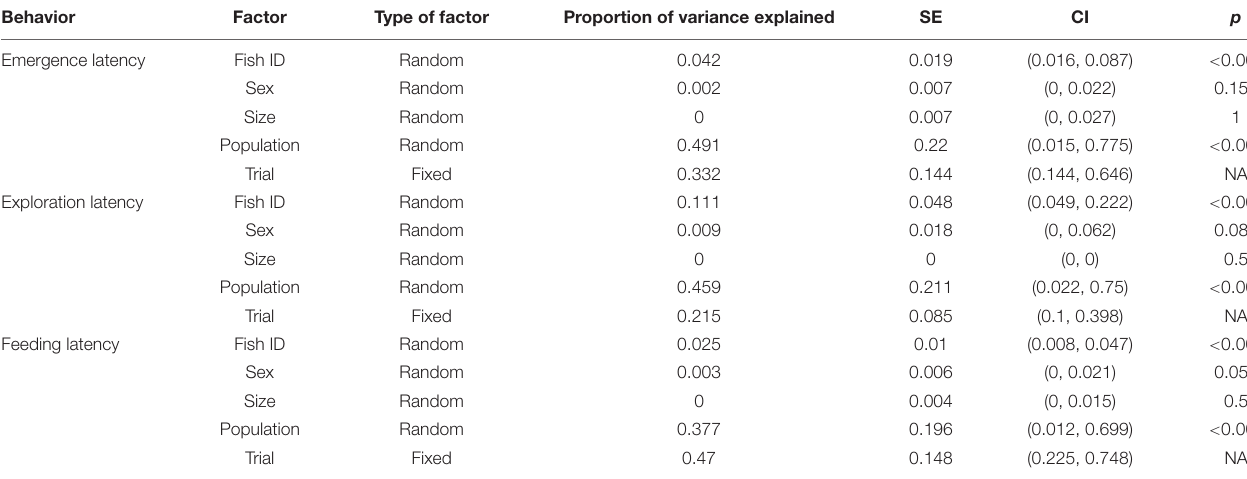
TABLE 7 | Proportion of variance contributed due to individual factors (random factors) as well as experimental conditions (fixed factors) for each behavior across populations. Behavior Factor Type of factor